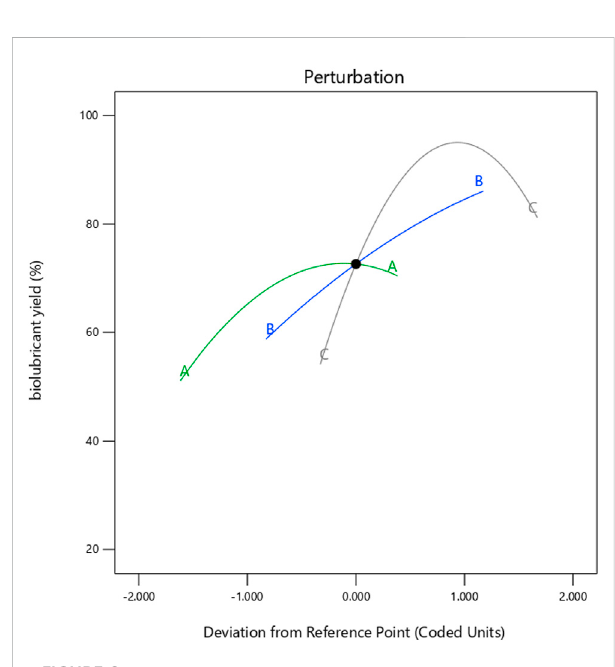
FIGURE 8 Pertubation plot for Jatropha biolubricant yield (%) as a function of Mole Ratio (A) , Time (B) and Temperature (C)